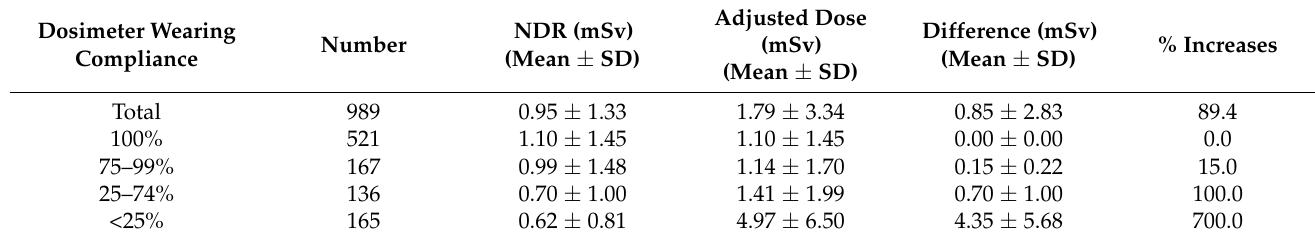
Table 2. Annual occupational radiation doses before and after complying with dosimeter wearing.